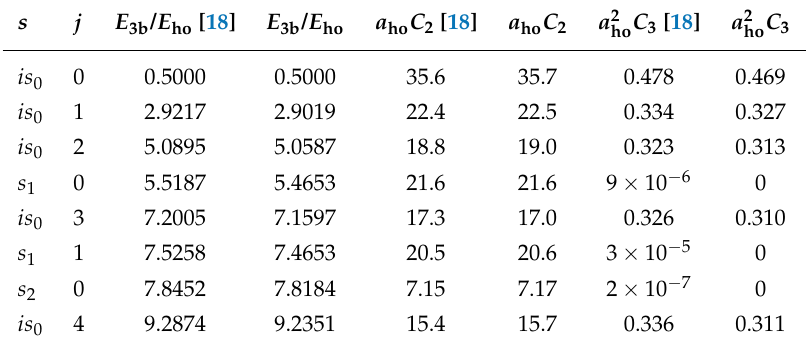
Table 1. Comparison of the results for E 3b /¯ h ω , a ho C 2 , and a 2 Ref. [18] for the energetically lowest eight eigenstates. To obtain these results, we have chosen an oscillator length a ho κ ∗ ≈